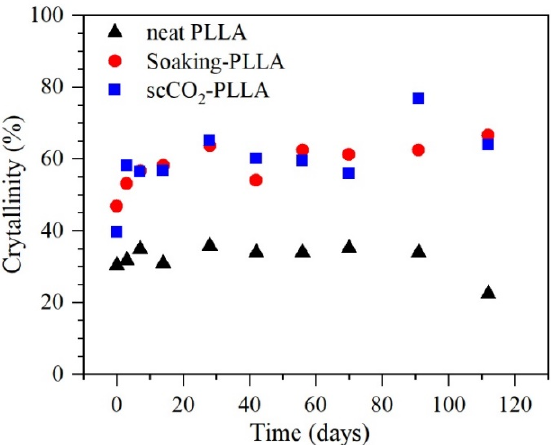
Figure 9. PLLA crystallinity evolution during the degradation study at 37 °C in PBS obtained with DSC analysis.